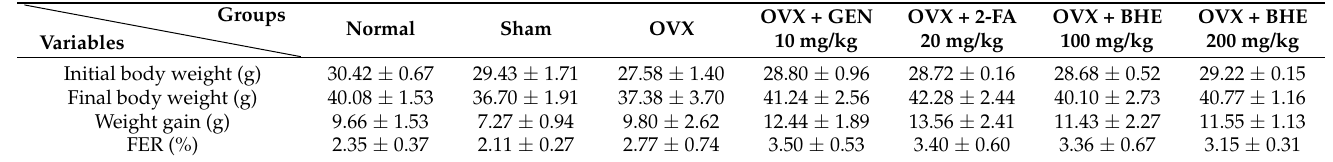
Table 1. Body weight and food intake of mice treated with standardized Benincasa hispida extracts (BHE,